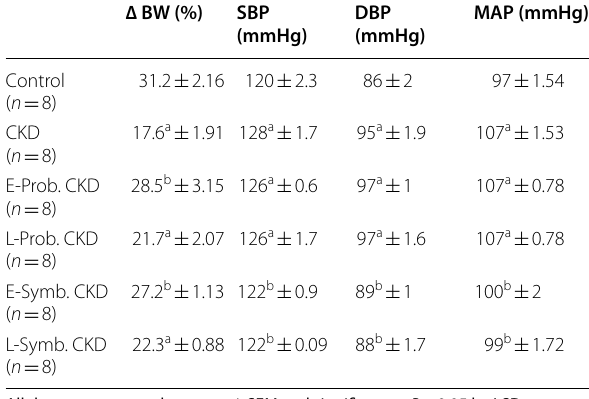
Table 2 Changes in body weight (∆ BW), systolic (SBP), diastolic (DBP) and mean arterial blood MAP pressure among different studied